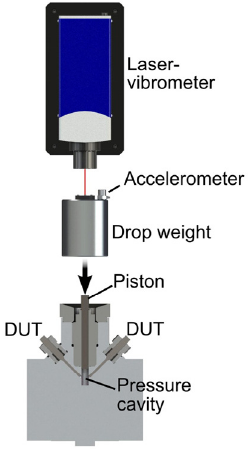
Fig. 7. Shock force measurement with a heavy force transducer showing modal oscillations. Fig. 8. Design of the MIKES pressure machine.